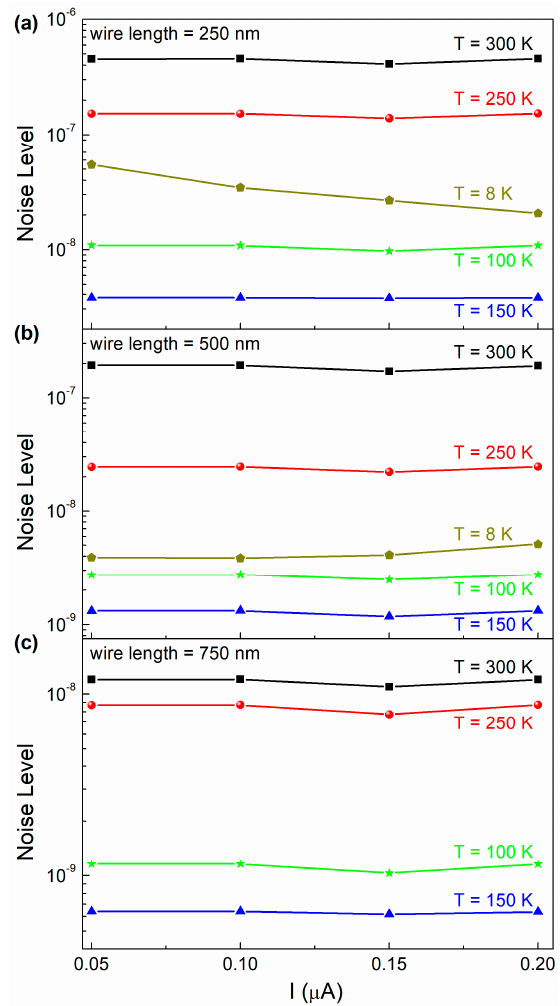
Figure 5. Current dependence of the nanodevices noise level in the low-bias region. The noise level dependence on the bias current, as evaluated from Equation (1), is shown for currents up to 200 nA and for devices of di ff erent lengths: 250 nm ( a ), 500 nm ( b ), and 750 nm ( c ). The investigated temperature range is from 8 to 300